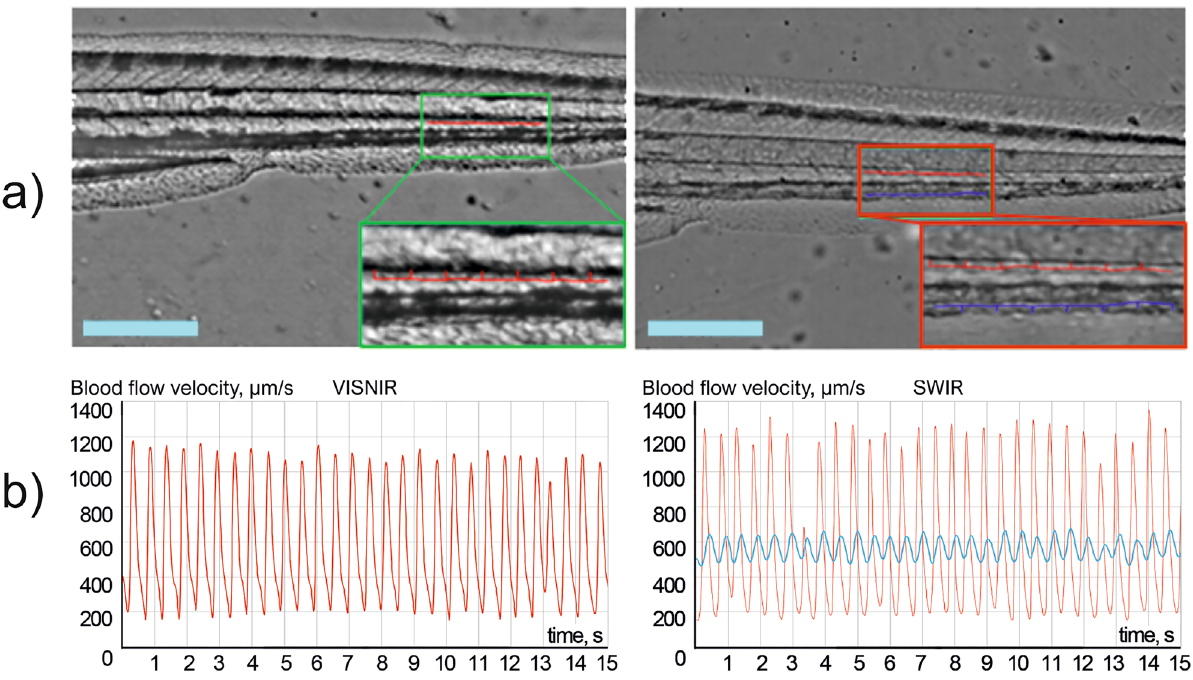
Figure 6. Raw images ( a ) and temporal dependences of blood flow velocity ( b ) in aorta dorsalis (red) and vena cardinalis (blue): VISNIR (left) and SWIR (right). Scale bar: 0.5 mm. Blood flow velocity in vena cardinalis was calculated only in SWIR due to the opaqueness of pigmentation that covers this vessel in VISNIR.